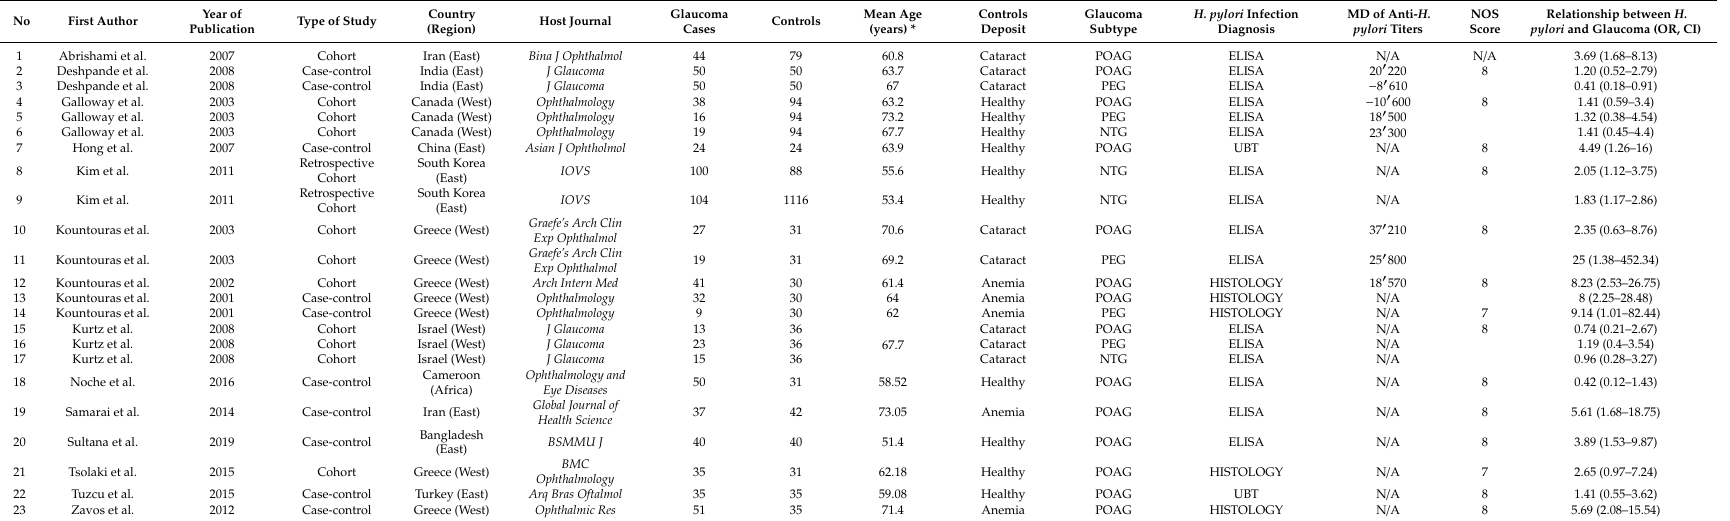
Table 1. The characteristics of the included